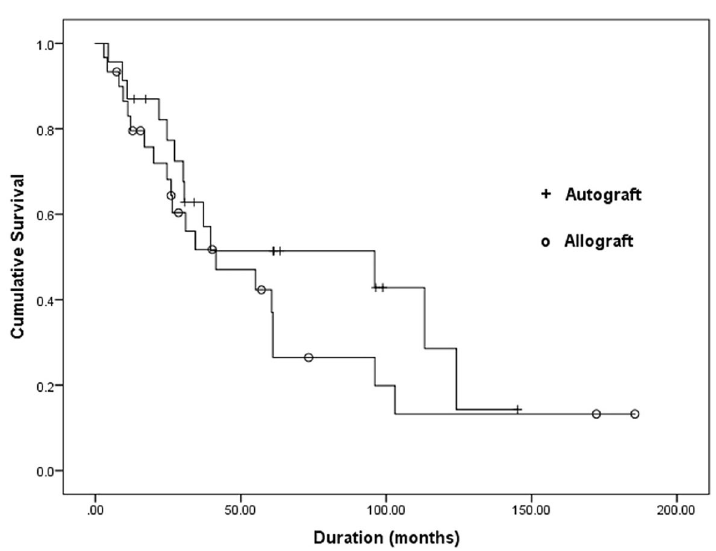
Figure 4. Kaplan–Meier survival curve of the bone graft in the subgroup of patients who received chemotherapy. There was no statistically significant difference between the nonvascularized autograft and allograft groups ( p =